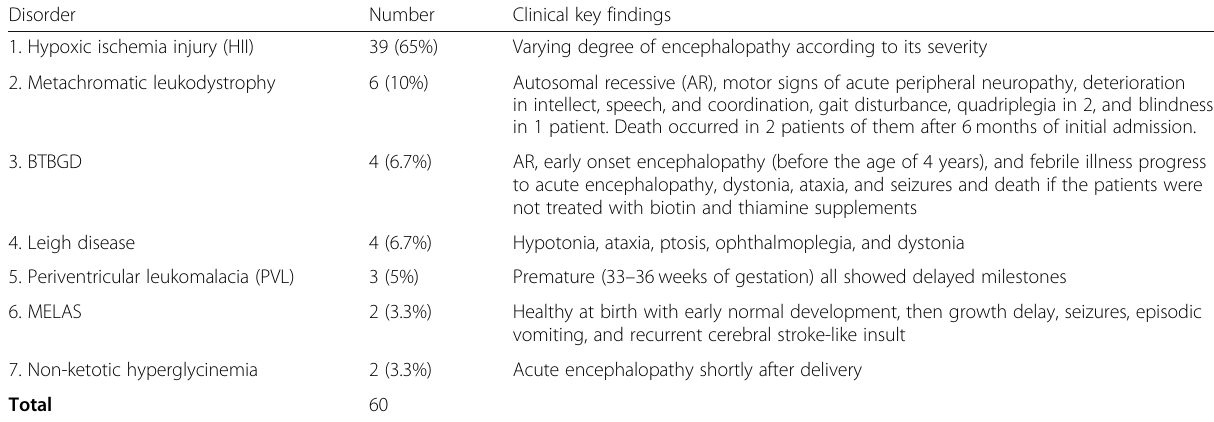
Table 1 General clinical findings of the selected group patients ( n =